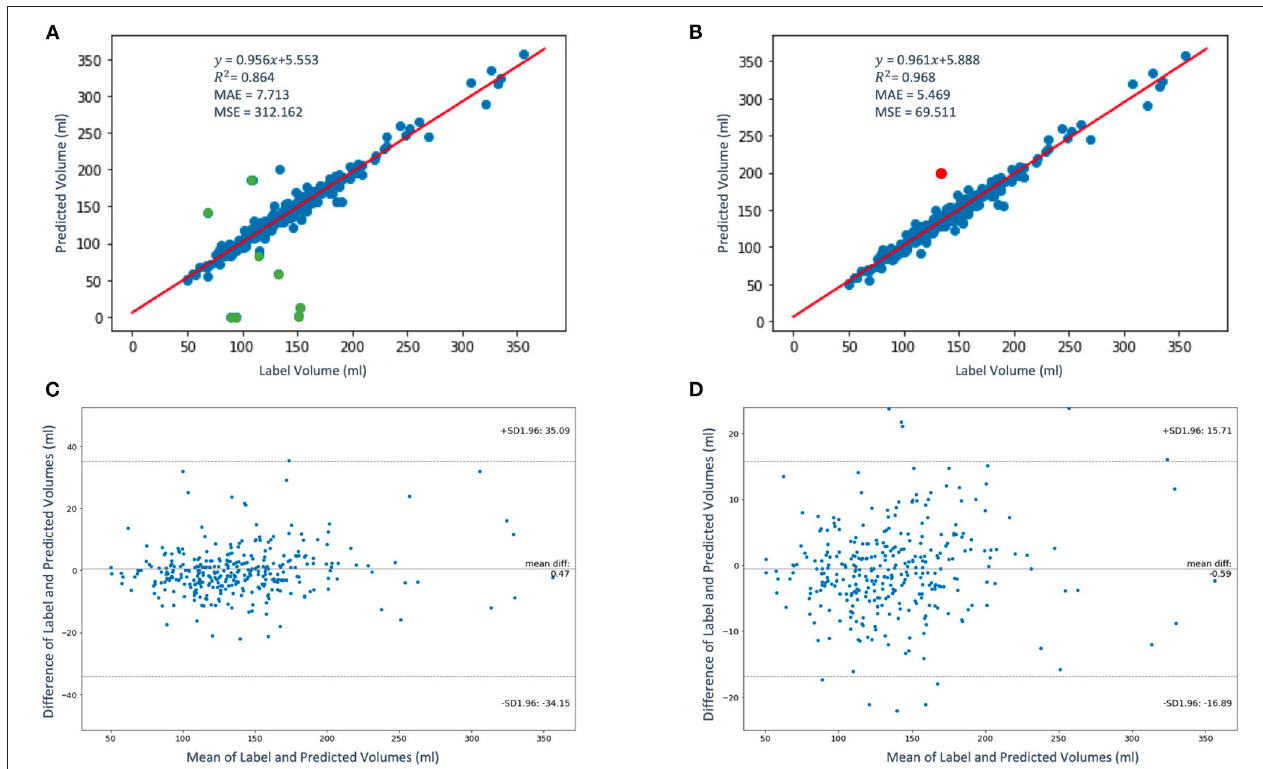
FIGURE 7 | The regression (A,B) and the Bland-Altman (C,D) plots of the label volumes vs. the predicted volumes using the proposed framework. The data points are shown in blue and green in panel (A) ; the green data points (9 out of 337) in the figure have been flagged by the QC condition as poor LAV estimates therefore eliminated in panel (B) . The red data point in panel (B) indicates one poor volume estimate (out of a total of 10) was missed by the imposed condition. In panels (C,D) , the upper and lower dashed horizontal lines represent the confidence interval at